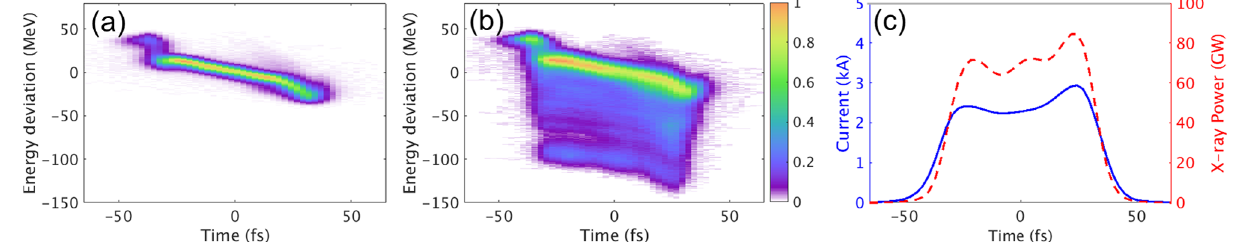
FIG. 4. Measurement examples of the collimated beam for hard x-ray FEL case with photon energy 7 keV. The electron beam energy is 12.5 GeV, and other machine parameters can be found in Table I. The electron beam longitudinal phase space is shown in (a) for lasing- off condition and (b) for lasing-on condition; in (c) the beam current profile and reconstructed FEL power profile are given. In this example the x-ray pulse energy is 4.8 mJ. Data taken on 3/15/2016.